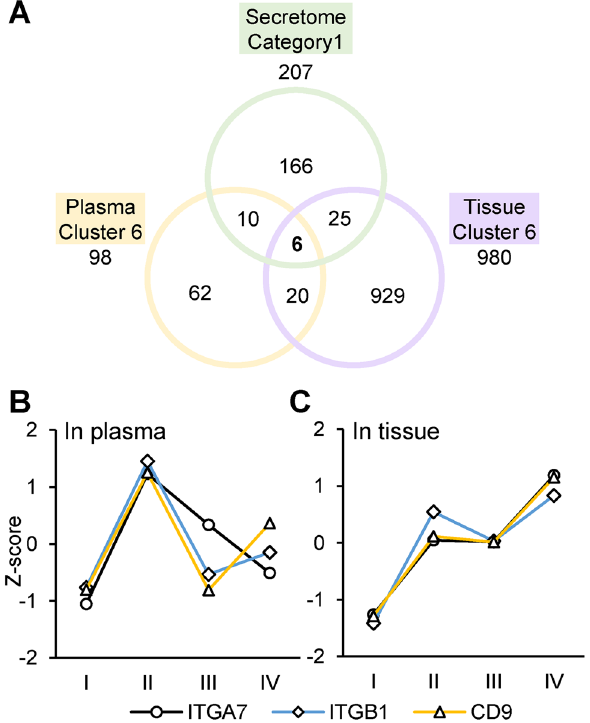
Figure 5. Overview of the proteins highly correlated with MMP-2 perturbation and disease progression. ( A ) The multi-layered proteome analysis result is presented as a Venn diagram depicting overlap between the secretome category 1, plasma cluster 6, and the tissue cluster 6. ( B , C ) Expression profile of the ITGA7- ITGB1-CD9 complex in plasma ( B ) and tissue ( C ) of CRC patients relative to cancer